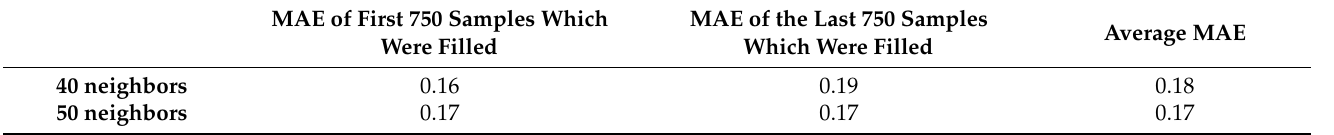
Table 7. MAE of nested-CNN without considering the MAE of